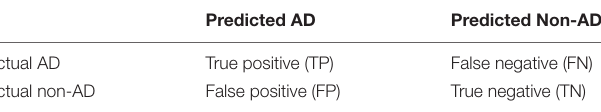
TABLE 2 | Representation of the confusion matrix for AD detection and metrics determination.